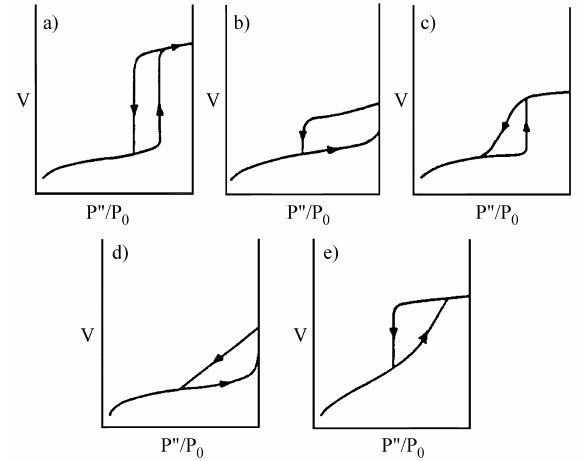
Types of hysteresis proposed by de Boer 4 .